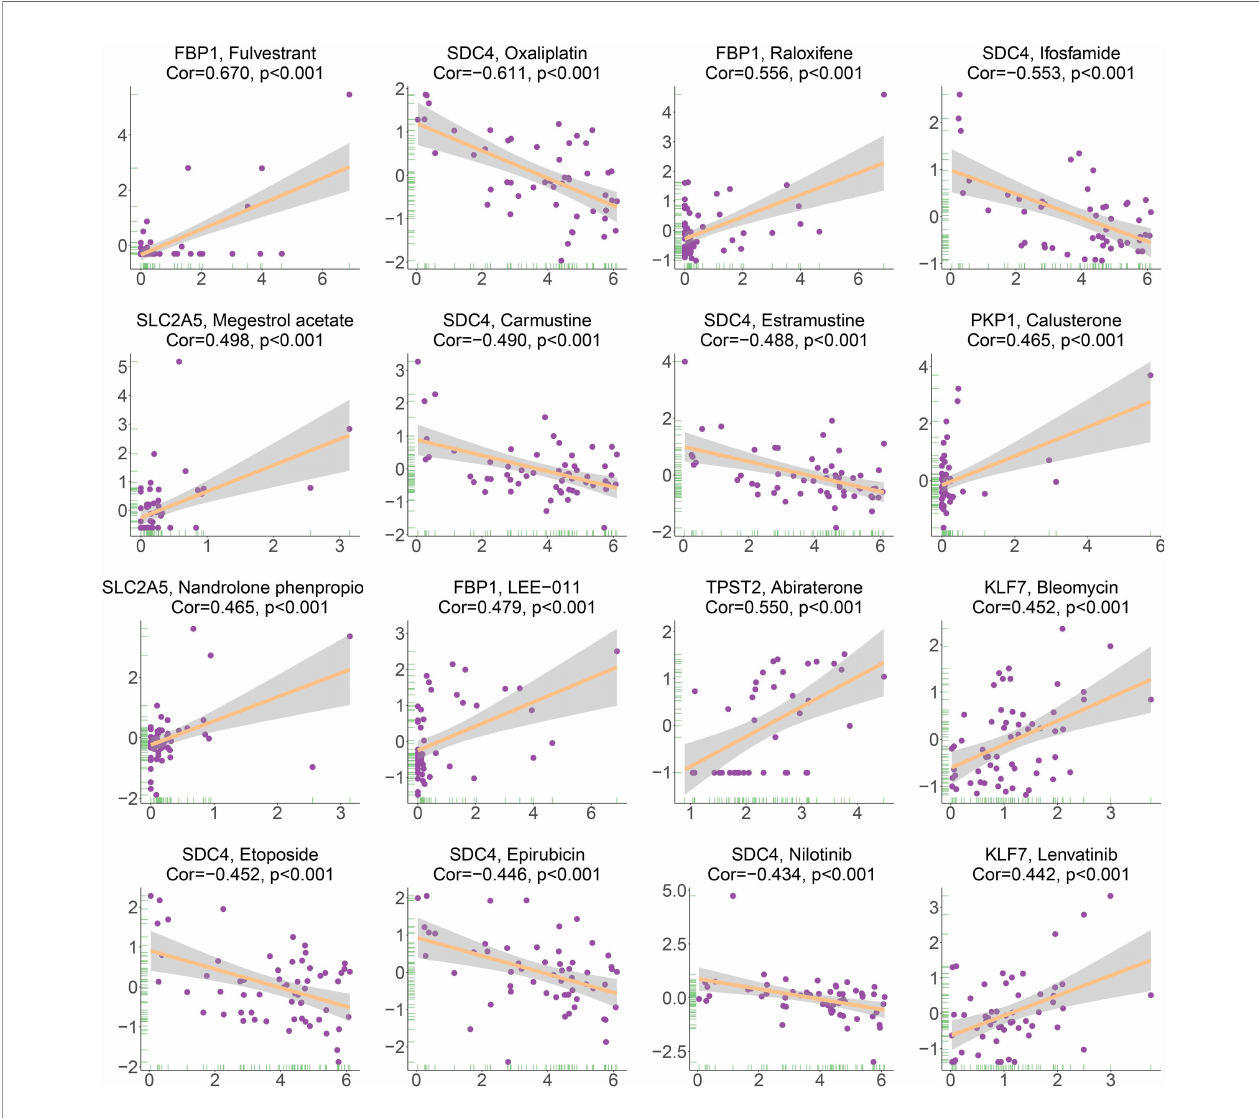
FIGURE 11 | Correlation between HAGS and drug sensitivity